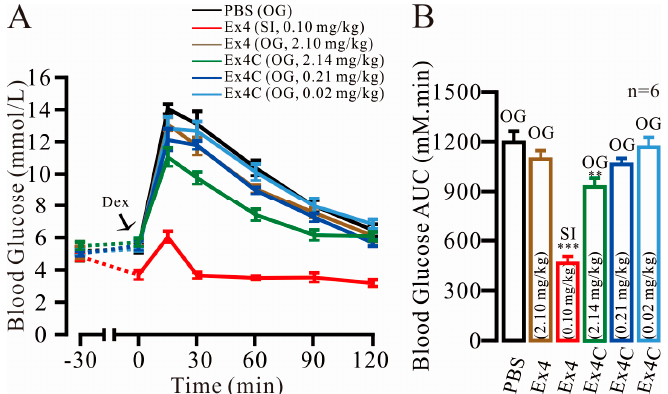
Figure 1. Intraperitoneal glucose tolerance test for Exendin-4 (Ex4) and Exendin4-cysteine (Ex4C) in C57BL/6J mice. ( A ) The blood glucose lowering effects of the Ex4 (subcutaneous injection) and Ex4C (subcutaneous injection/oral gavage) treatments in C57BL/6J mice; ( B ) Area under the curve of the blood glucose level during the intraperitoneal glucose tolerance tests. The data are presented as the mean ± SEM, n = 6, *** p < 0.001.